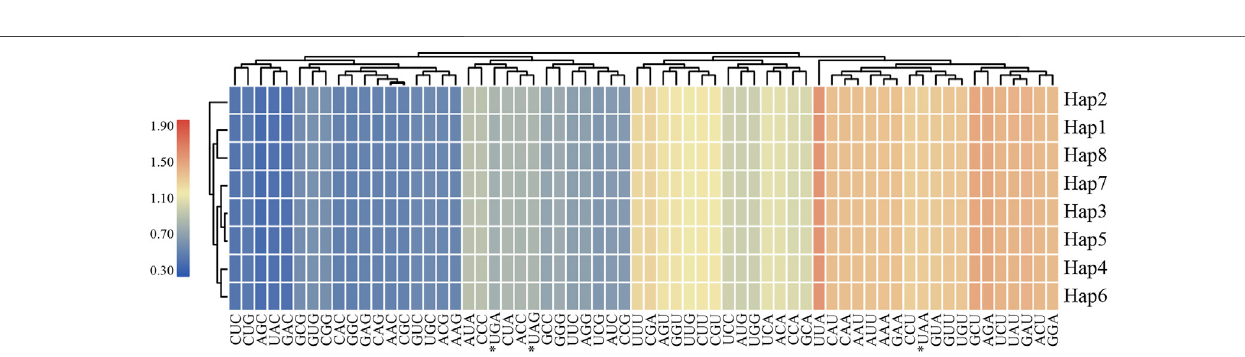
Frontiers in Genetics |